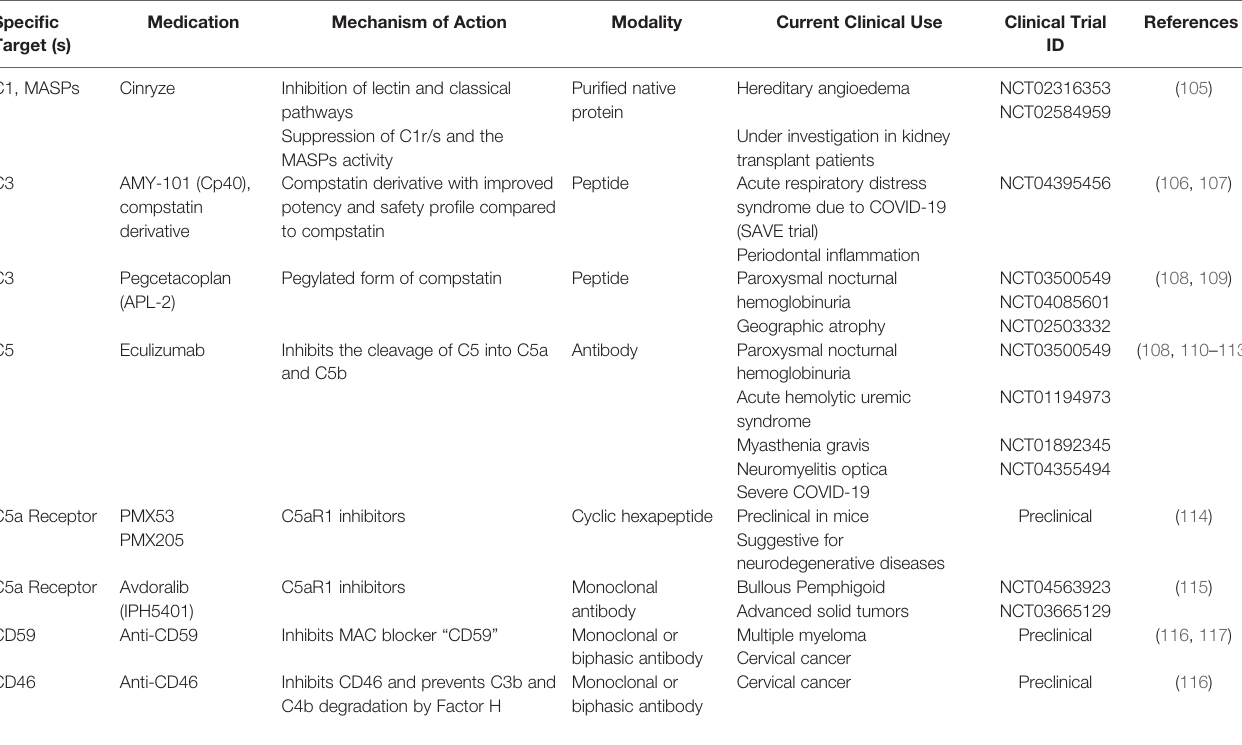
TABLE 1 | Complement-targeting medications in different pathological